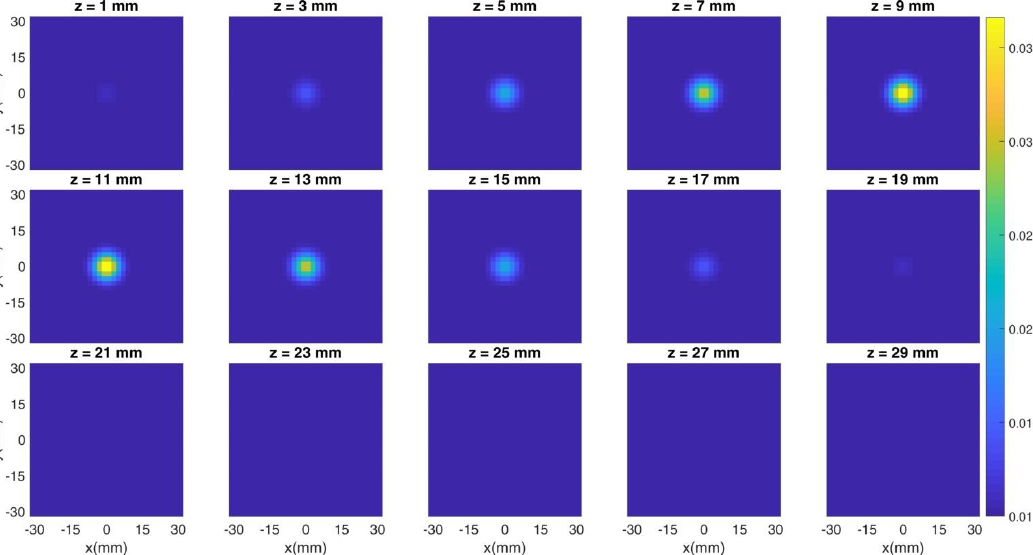
Figure 8. Cross sections of the simulated tomography at di ff erent depths. The inclusion is set in the center of the x-y plane and at a 10